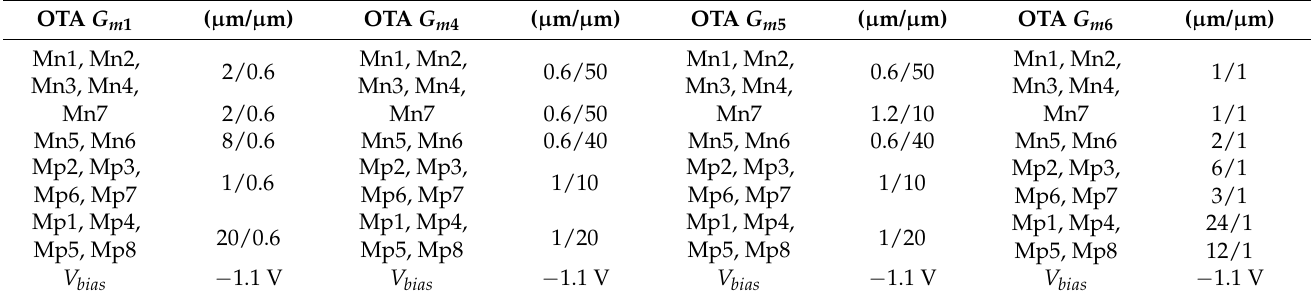
Table 13. Transistor values of each OTA design in Figure 13.